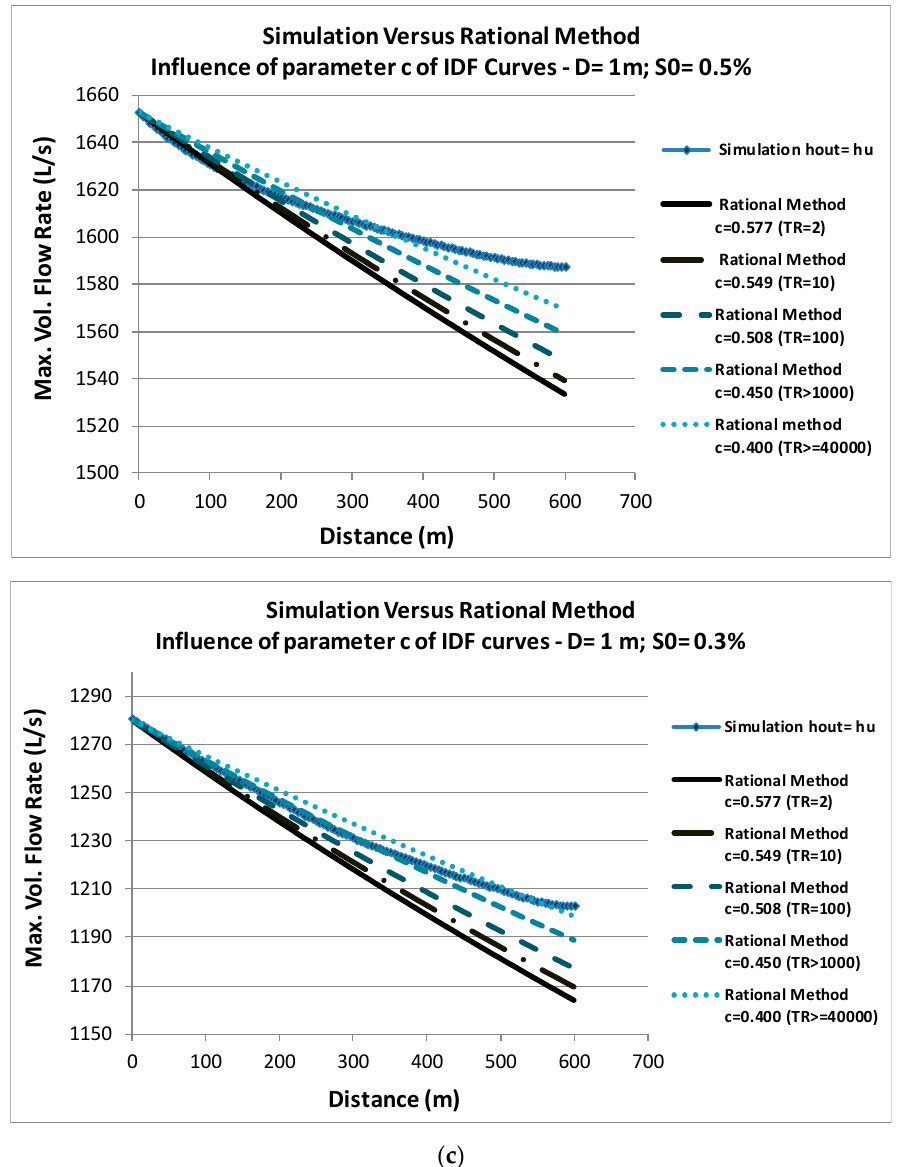
Figure 3. Simulation in open channel gradually varied unsteady flow versus rational method along a pipe sewer for known input symmetric triangular hydrographs in the upstream extremity for sewer slopes of 0.3 and 0.5%. ( a ) Diameters of 200, 400, and 600 mm and different downstream boundary conditions. ( b ) Diameters of 1 and 2 m, different downstream boundary conditions, and two criteria of average velocity in the rational method. ( c ) Diameter of 1 m and different values of the exponent c of IDF curves in the rational method.